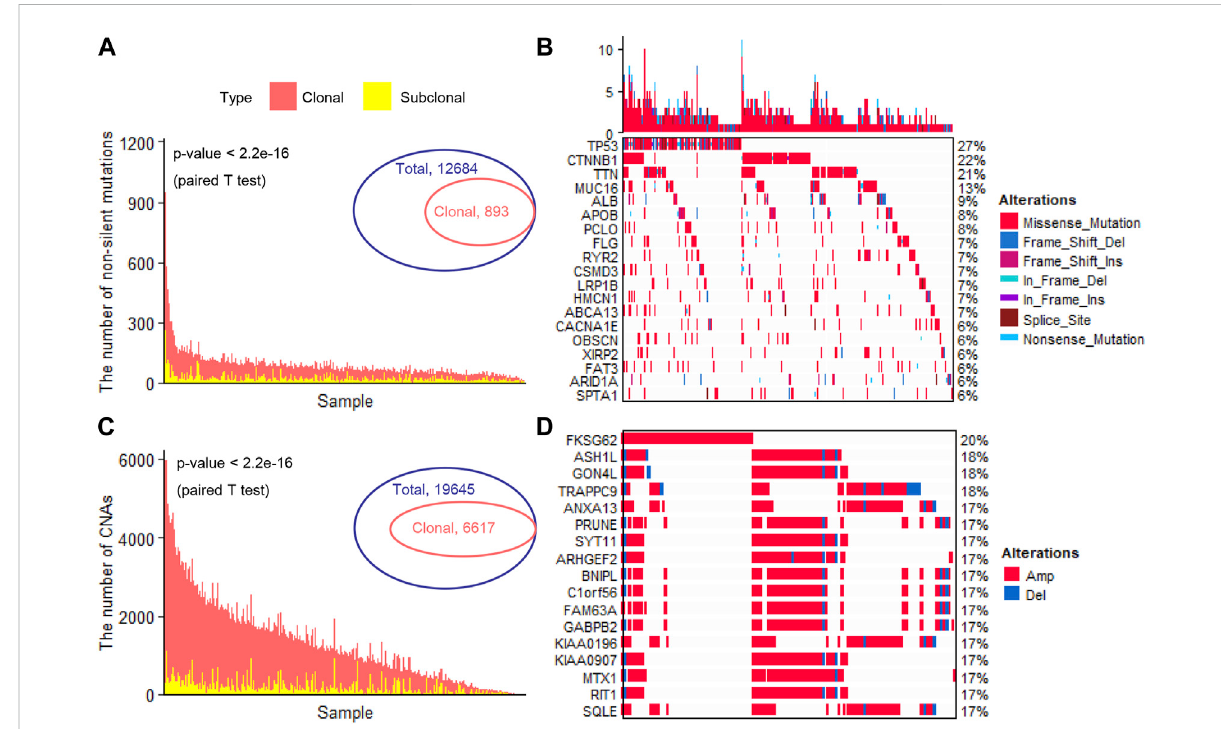
FIGURE 1 Identi fi cationofclonalalteredgenes (A) .Thenumberofclonalandsubclonalnon-silentsomaticmutationsineachpatient (B) .Thelandscapeof the frequently clonal altered somatic mutations (C) . The number of clonal and subclonal CNAs in each patient (D) . The landscape of the frequently clonal altered CNAs. CNAs, copy number alterations; Amp, Ampli fi cation; Del,